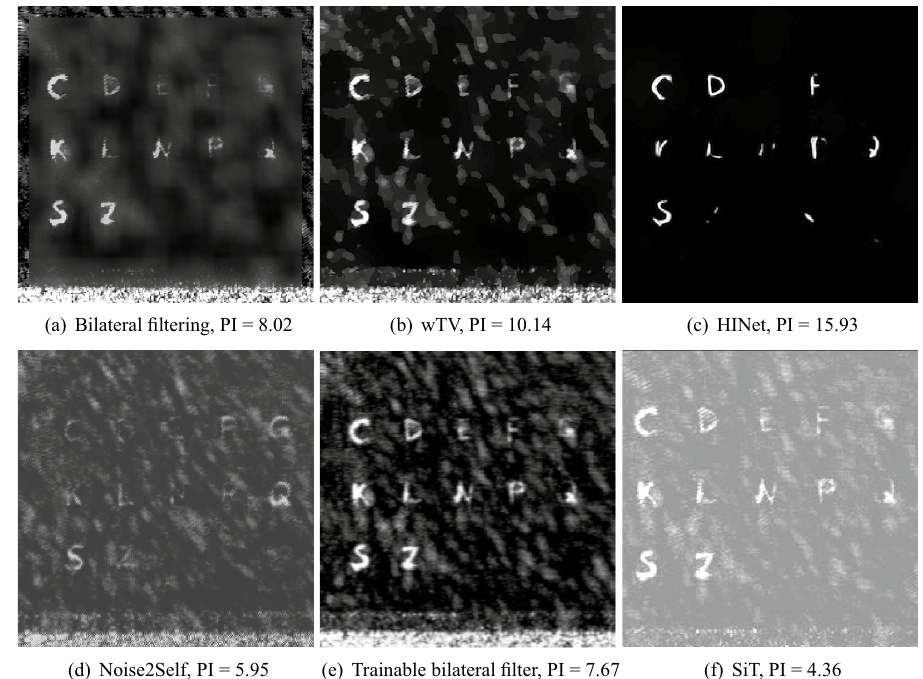
Figure 8. Comparison of different algorithms on the same THz image written on Xuan paper (Fig. 6a).